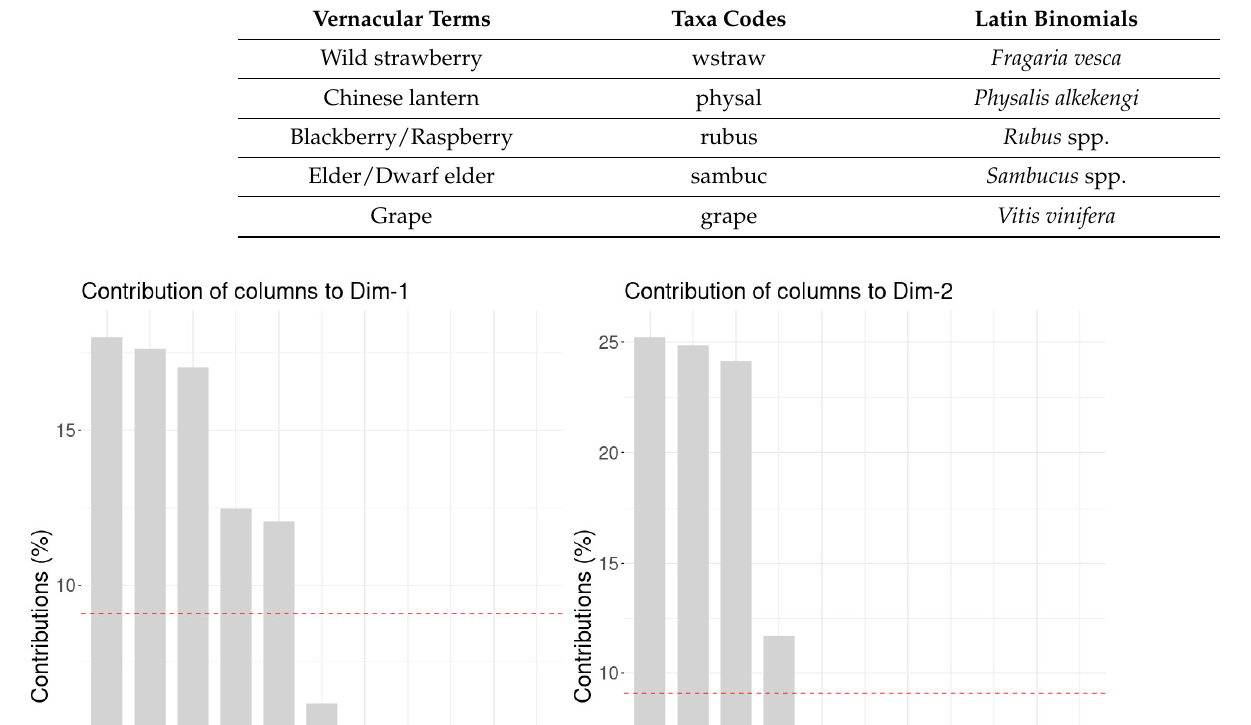
Figure 9. Correspondence analysis plots of wild taxa and sites (triangles denote Pannonian sites; circles denote Continental sites. See Table 1 for full taxa names).